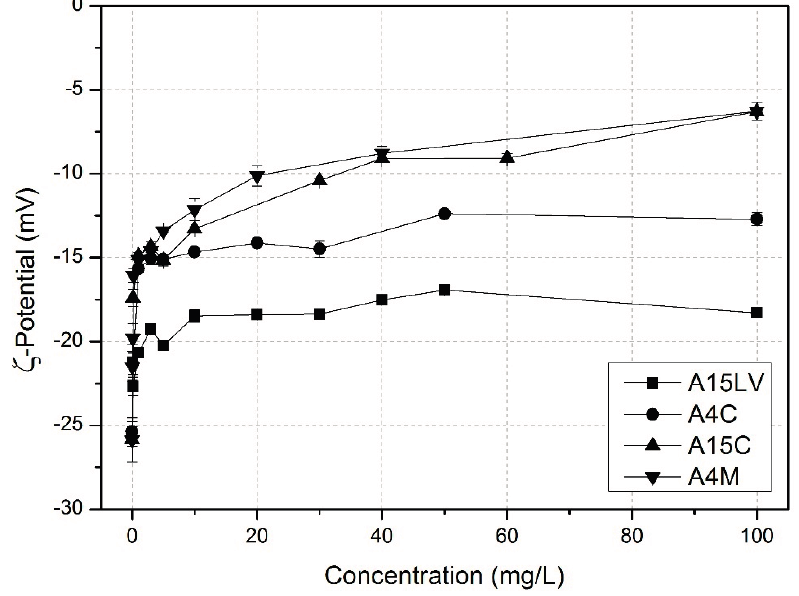
Figure 7. ζ -potential (expressed in mV) of silica particles dispersed in water at 20 °C in the presence of the increased amount of methylcellulose with different molar masses. Concentrations from 0 to 100